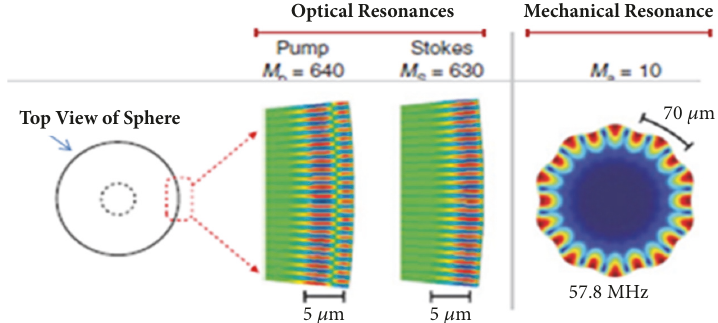
Figure 14: Simulation of interacting optical and mechanical modes at the surface of a spherical micro-device [adapted from